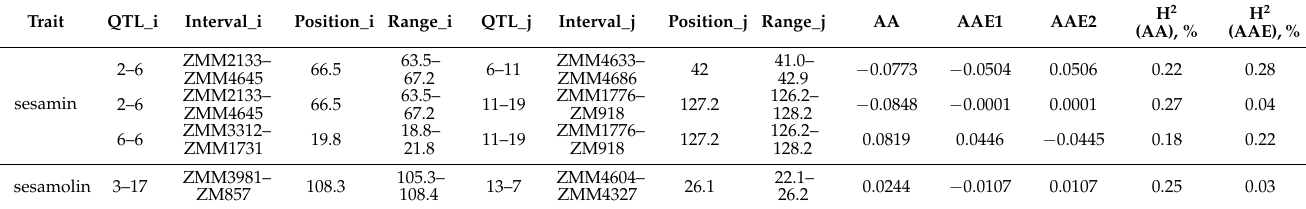
Table 4. Digenic epistatic interactions detected for sesamin and sesamolin in the RIL population in two environments. Trait